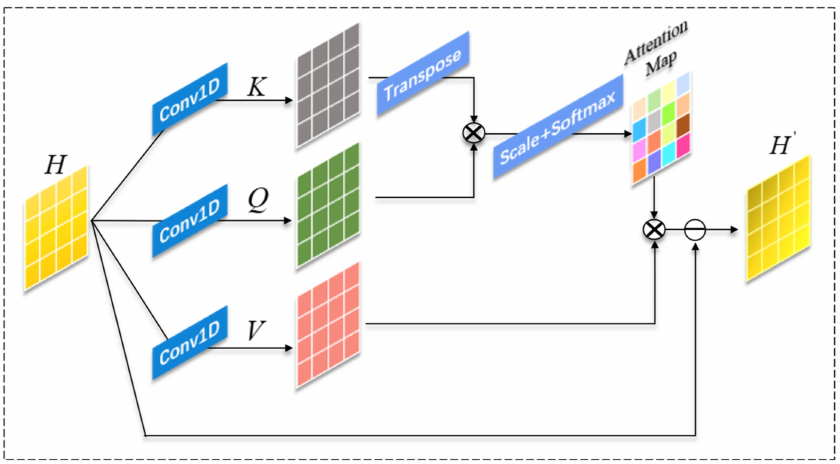
Figure 3. Details of the Offset Transformer structure. ⊕ denotes add operation. subtraction